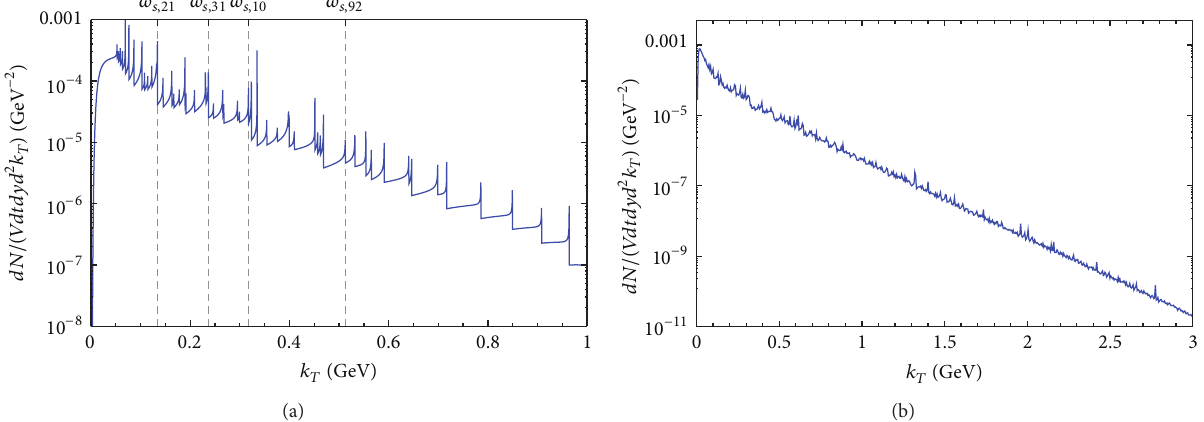
Figure 16: Spectrum of synchrotron radiation by 𝑢 quarks at 𝑒𝐵 = 𝑚 2 𝜋 , 𝑦 = 0 , and 𝜙 = 𝜋/3 : (a) contribution of 10 lowest Landau levels 𝑗 ≤ 10 ; several cutoff frequencies are indicated; (b) summed over all Landau levels. 𝑚 𝑢 = 3 MeV, 𝑇 = 200 MeV. Adopted from [7].